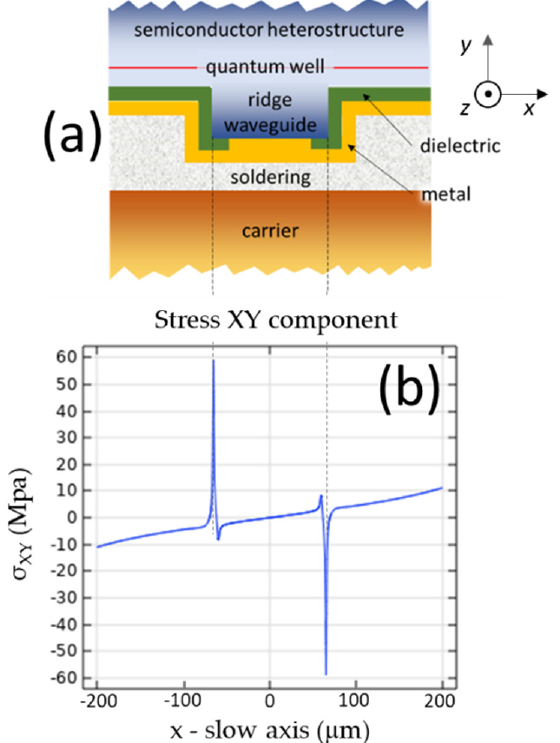
Figure 3. Stress calculation for a HPLD. ( a ) Schematic of upside-down mounted HPLD in which index guiding is achieved through a ridge waveguide. ( b ) 2D distribution of the stress tensor component σ xy obtained through a FEM calculation with COMSOL Multiphysics ® . due to the material structure [16]: It is useful to define the intrinsic anisotropy ∆ n 0 ii